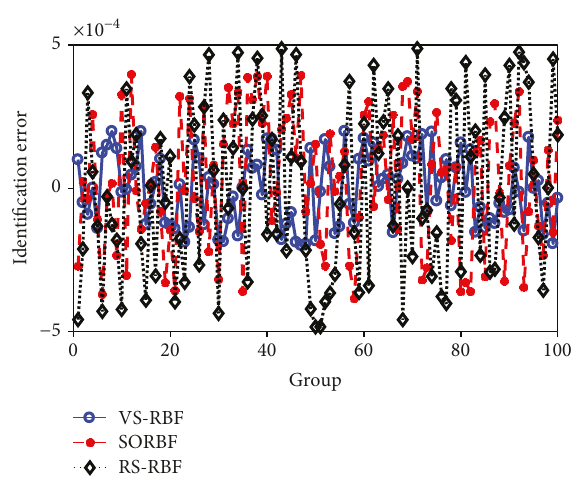
Figure 9: Justi fi cation of UCI datasets.